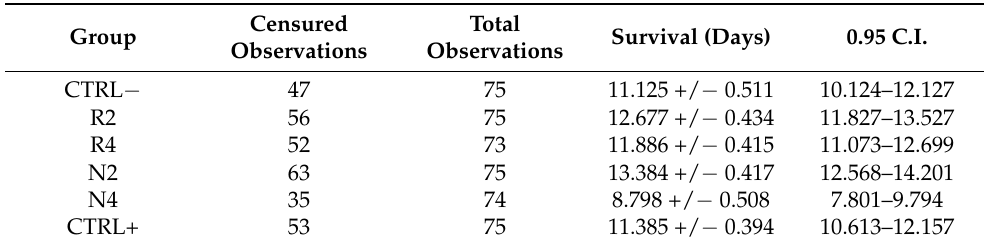
Figure 3. Kaplan–Meier survivorship curves for the N. ceranae -infected treated groups (R2, R4, N2, N4), CTRL+ and CTRL − . Crosses indicate right-censored observations (cens.). Table 3. Censored and total observation, and mean survival +/ − s.e. in the treated groups (R2, R4, N2, N4), the CTRL − and